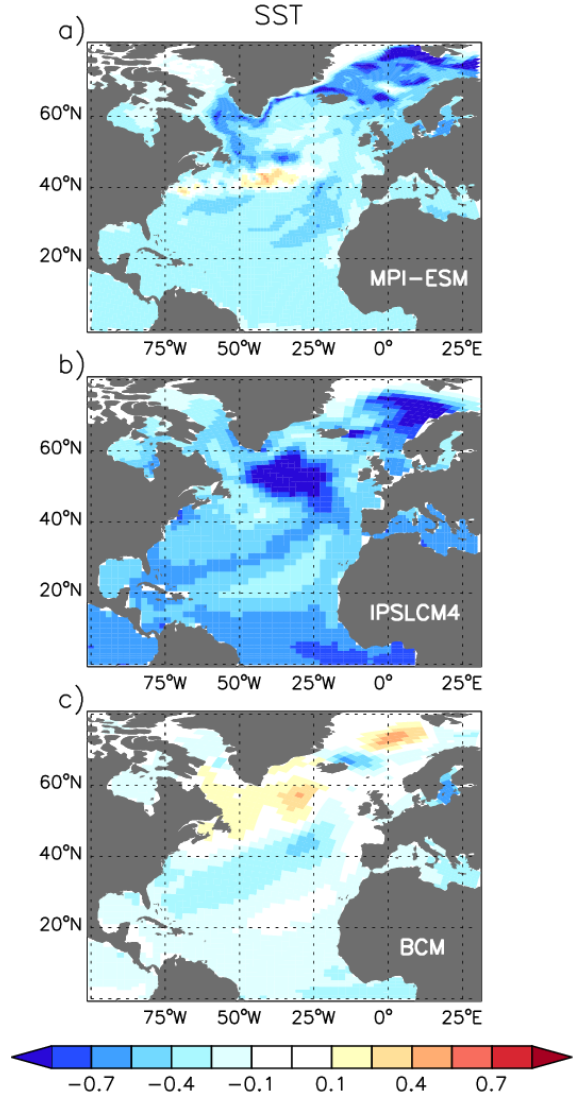
Figure 5. Composite for North Atlantic SST (in K) with respect to the cold events in the AMO index (blue lines in Fig. 3) following the major volcanic eruptions in years AD1258 and 1815 (BCM only AD1815) taking into account 15 years centred around the coldest year in MPI-ESM (a) , IPSLCM4 (b) and BCM (c) . The composites are based on annual anomalies (with respect to the period AD850 to 1849 in MPI-ESM and IPSLCM4 and AD1550 to 1999 in BCM) with a 21-year running mean filter applied. For IPSLCM4, the data have been linearly detrended prior to the analysis to account for the model